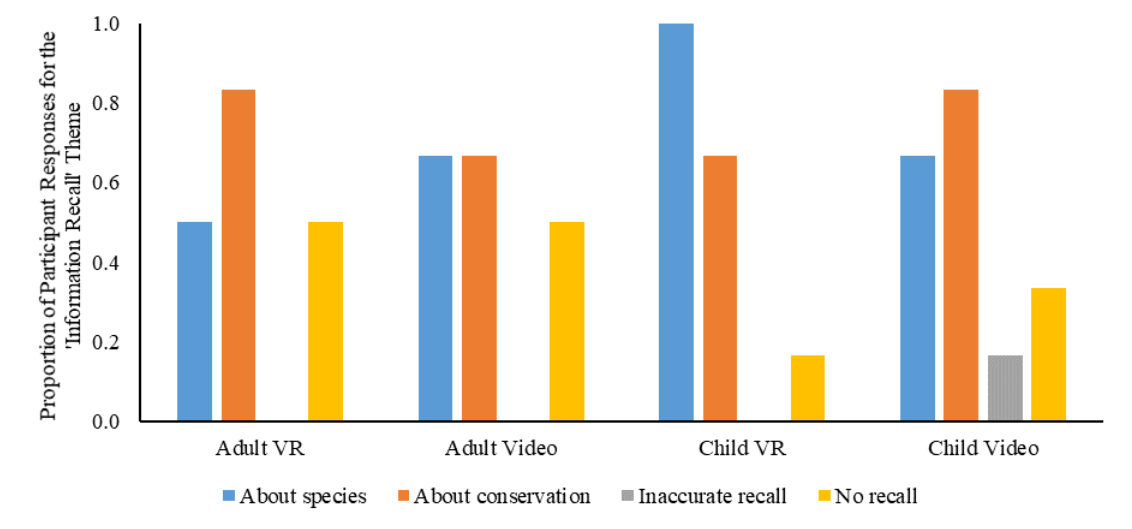
Summary of ‘Information Retrieval’ Theme by